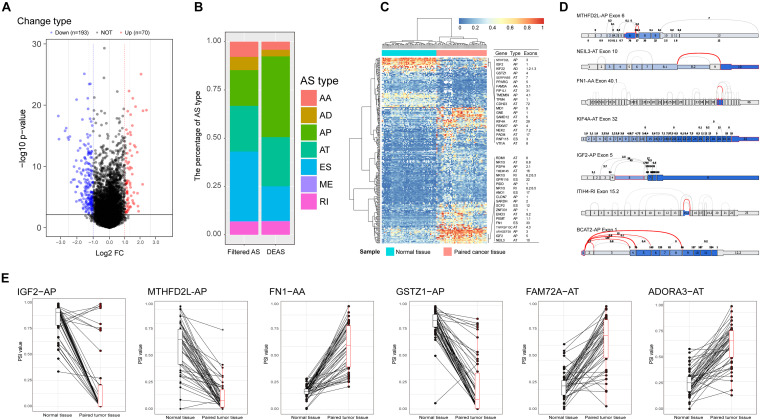
Identification of hepatocellular carcinoma (HCC)-related aberrant alternative splicing (AS). (A) Differences in AS events between paired HCC tissue and paracancerous tissue. Volcano plot of the differentially expressed alternative splicing (DEAS) identified in HCC; the blue and the red points represent the DEAS with statistical significance (|log(FC)| ≥ 1, adj p < 0.05). (B) Proportions of different AS types among filtered AS and DEAS. (C) Heat map of the DEAS. The horizontal axis shows the clustering information of samples divided into two major clusters: adjacent normal tissue (N = 50) and paired tumor tissue (N = 50); the left longitudinal axis shows the clustering information of DEAS. The gradual change of color from green to red represents the alteration of expression of DEAS from low to high. (D) Splice graph of some representative DEAS. The thin exon sections represent untranslated regions and the thick exon sections represent coding regions. The exons are drawn to scale, and the connecting arcs represent splice paths. (E) Differences in percent spliced in values of AS events between HCC and paired adjacent normal tissues.